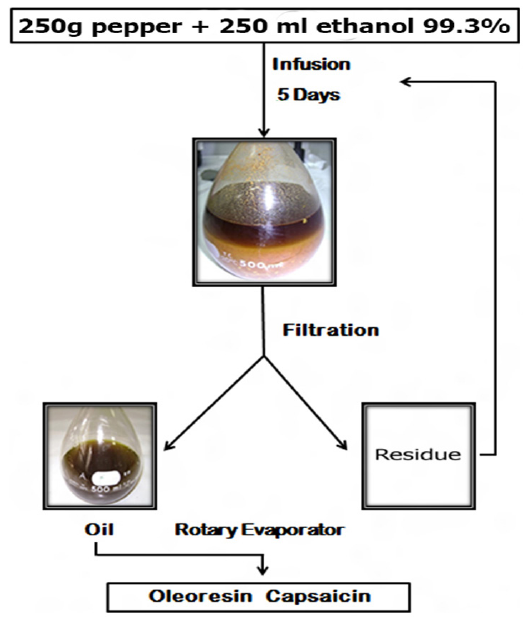
Figure 1. Procedure used to obtain from chili peppers ( Capsicum frutescens or Capsicum baccatum ).